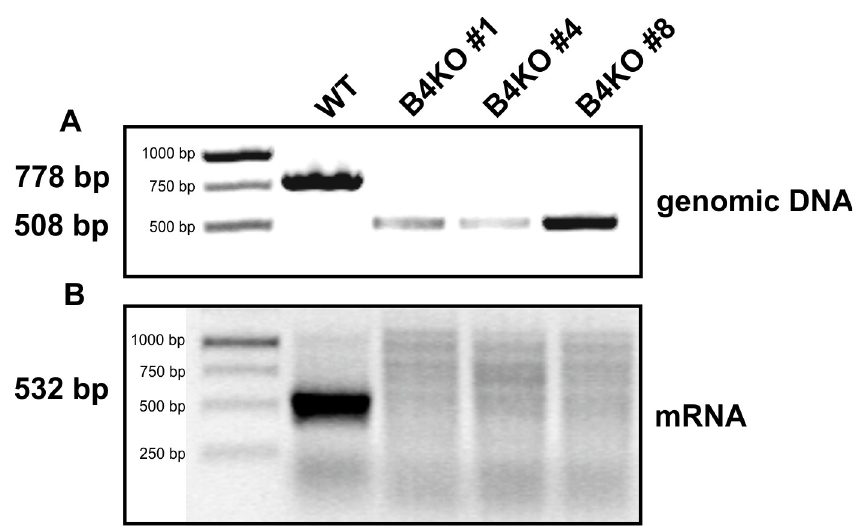
Fig 6. CRISPR-Cas9 knock-out of the SLC35B4 gene in HepG2 cells. Genomic DNA (A) and total RNA (B) were isolated from SLC35B4-deficient (B4KO) and wild-type (WT) HepG2 cells and PCR (genomic DNA) or RT-PCR (mRNA) reaction was performed using SLC35B4 gene-specific primers. Products were separated in 2% agarose gel, containing ethidium bromide.